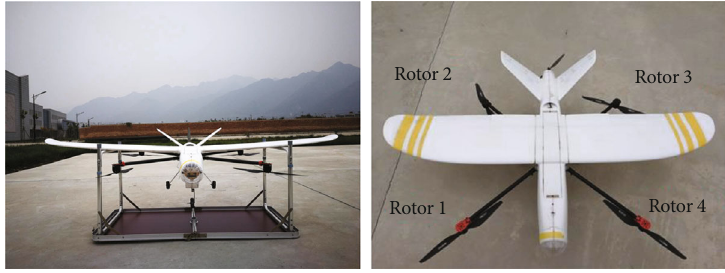
Figure 16: Target Table 1: Parameters of the target Quad-Plane.